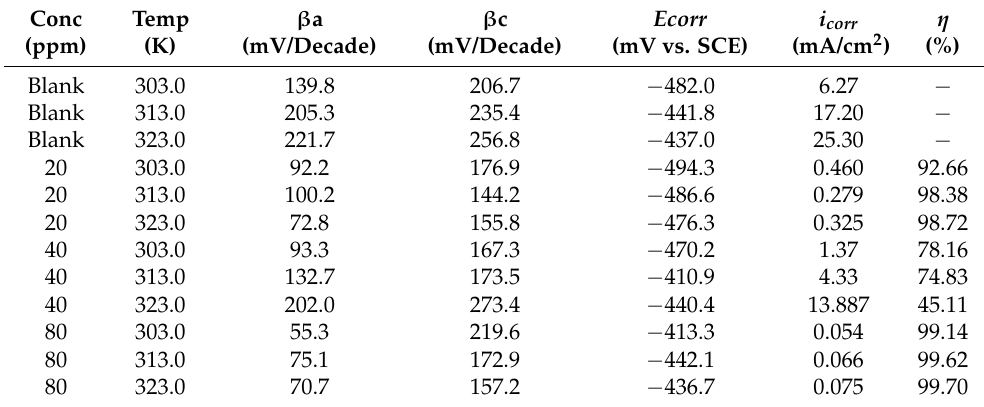
Table 1. Results of potentiodynamic